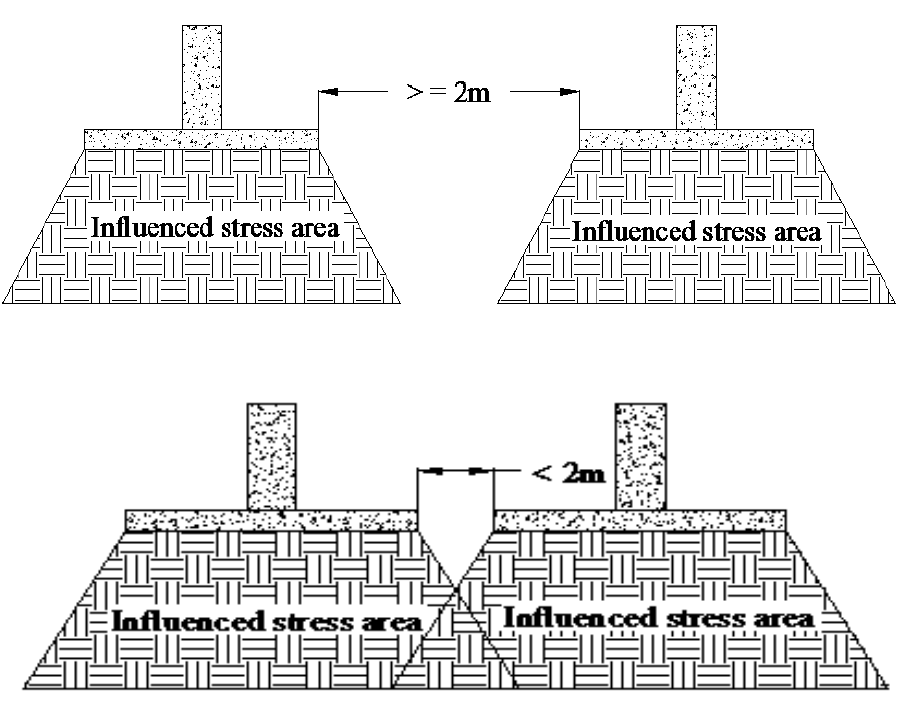
Fig. 15. Influenced stress area on clayey soil after application of load on footing.